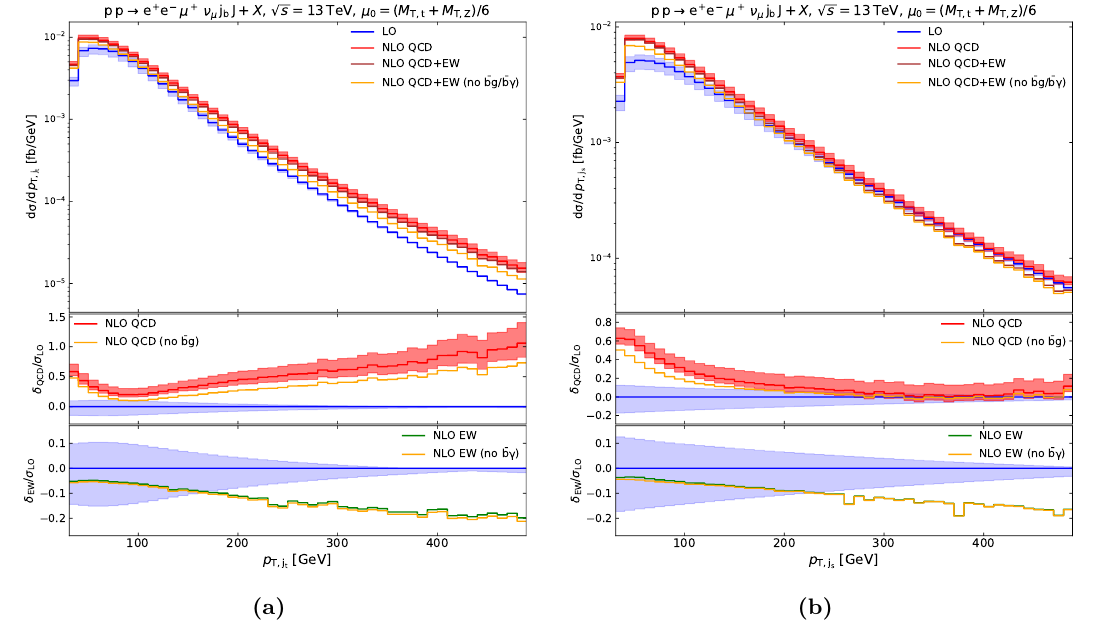
Figure 5. Transverse-momentum distributions for the top-decay jet j b and spectator jet j s